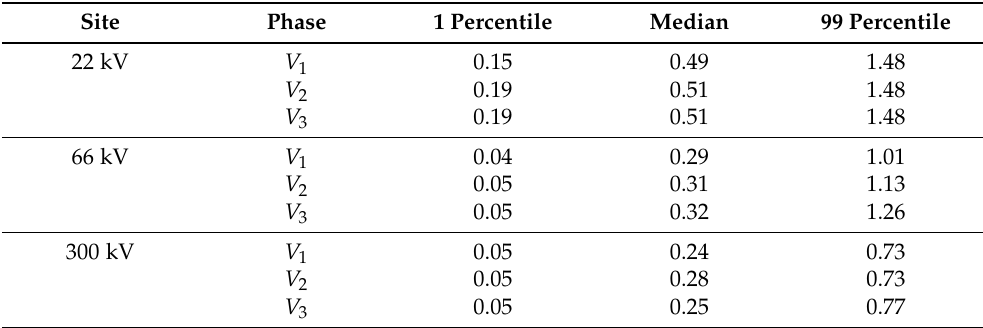
Figure 6. Cumulative distribution function (CDF) of total harmonic distortion (THD) for three sites (see legend) for the phase-to-ground voltage V 1 plotted together for comparison. Binning and data basis is the same as for Figure 5. ( Top ): CDFs for each site (see legend). ( Bottom ): Difference between the CDFs for 22 and 300 kV as well as the 66 and 300 kV sites, respectively (see legend). See Table 2 for summary statistics. For higher voltage levels, the distribution shifts to smaller THD values—there is less noise in the system. Table 2. Summary statistics for the distribution of total harmonic distortion (THD) per site and phase. Site Phase 1